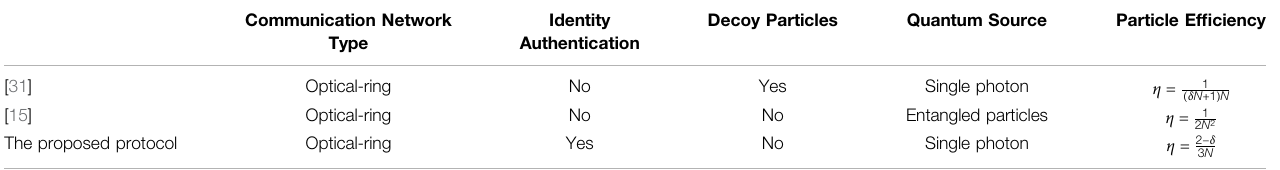
TABLE 4 | Comparison of several multi-party QKA